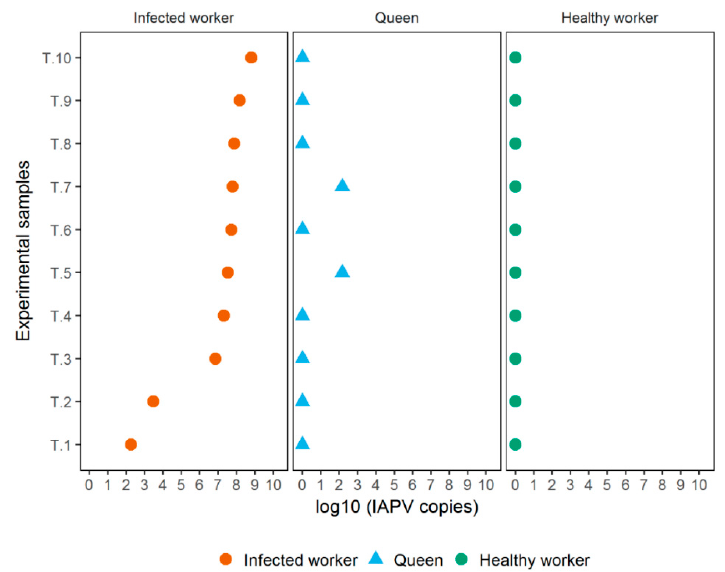
Figure 3. Virus titers of inoculated and non-inoculated workers, and queens in a dual choice experiment. IAPV titers in inoculated workers ranged from 1.84 × 10 2 to 6.43 × 10 8 copies/µL, but no virus was detected in the non-inoculated workers. The queens were in trophallactic contact with both worker groups but did not show IAPV-infections, except two with low titers (1.43 × 10 2 and 1.46 × 10 2 copies/µL). T1–T10 = independent experimental replicates.